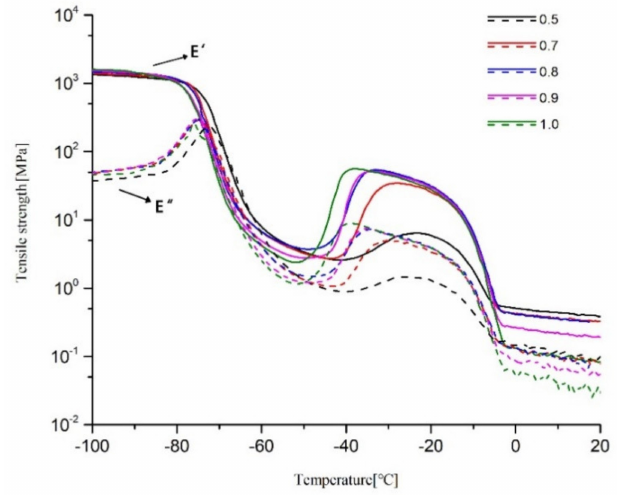
Figure 5. Storage and loss modulus of